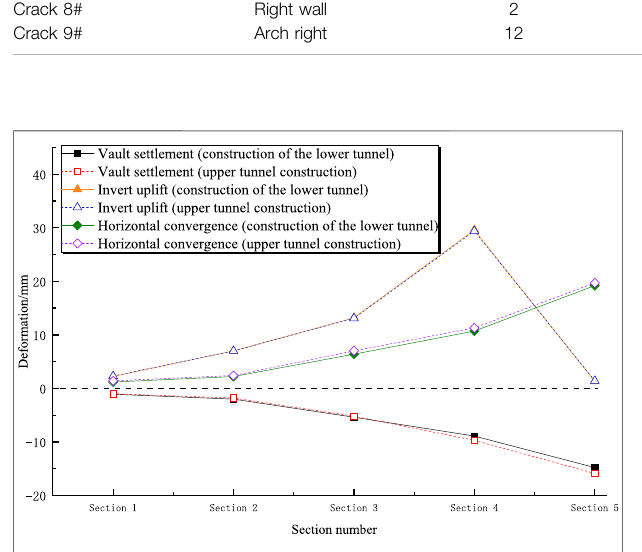
FIGURE 14 | Displacement result analysis at different cross-sections